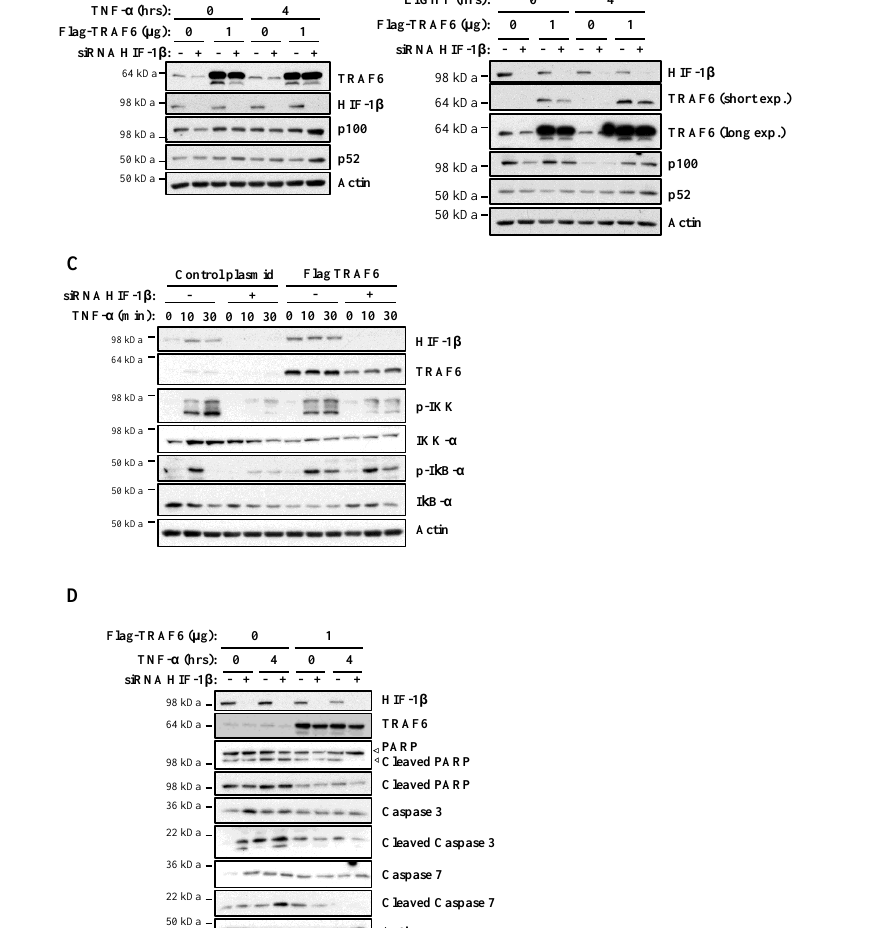
Figure 7. Exogenous TRAF6 is able to rescue HIF-1 β loss in terms of NF- κ B signalling and cell survival. ( A ) HeLa cells were transfected with control and HIF-1 β siRNA oligonucleotides as well as with 1 µ g of control or TRAF6 plasmid, prior to treatment with 10 ng / mL of TNF- α for 0 or 4 h. Whole cell lysates were collected, and Western blot analysis for the indicated proteins was performed. Actin was used as a loading control. ( B ) HeLa cells were transfected as in 7A , but, where indicated, also treated with 100 g / mL LIGHT for 4 h prior to lysis and Western blot analysis. Actin was used as a loading control. ( C ) HeLa cells were transfected as in 7A , and treated where indicated with 10 ng / mL TNF- α for the depicted periods of time prior to lysis and Western blot analysis. Actin was used as a loading control. ( D ) HeLa cells were transfected, treated and analyzed as in 7A